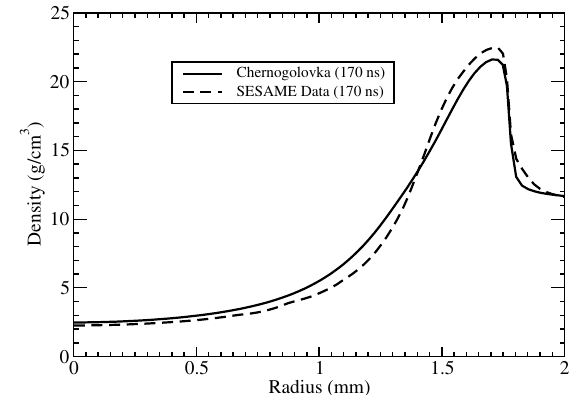
FIG. 17. Temperature vs radius at t (cid:3) 20 ns , using the beam and target parameters shown in Fig. 5, but using two different equation-of-state models, namely, SESAME and a semiempir- ical model.